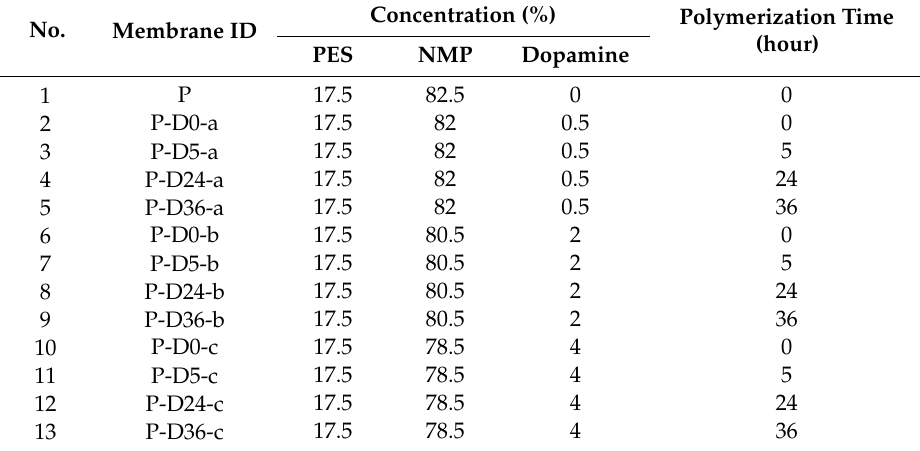
Figure 1. Illustration of membrane fabrication method showing the step of membrane fabrication including dopamine polymerization. Table 1. Composition of polymer solution for membrane fabrication.